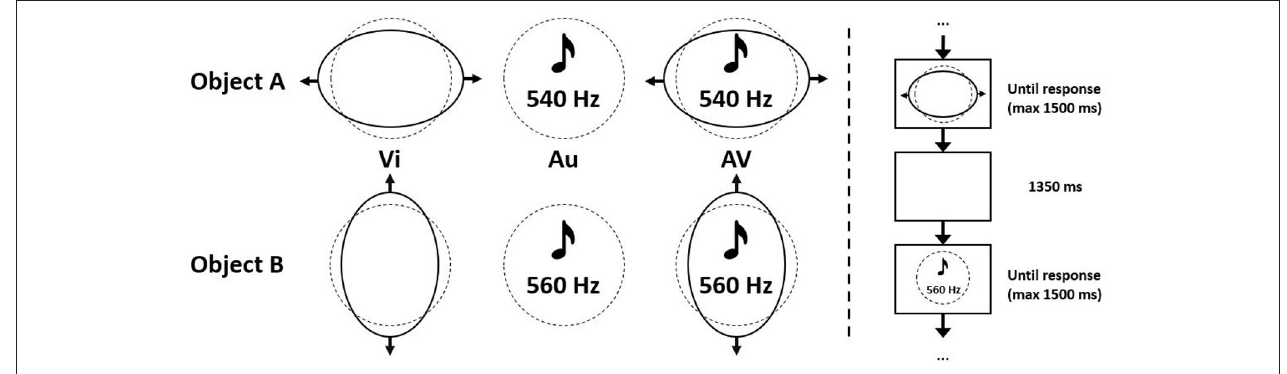
FIGURE 1 | Stimulus details of the audiovisual dominance task, including characteristics of objects A and B. Created based on Giard and Peronnet